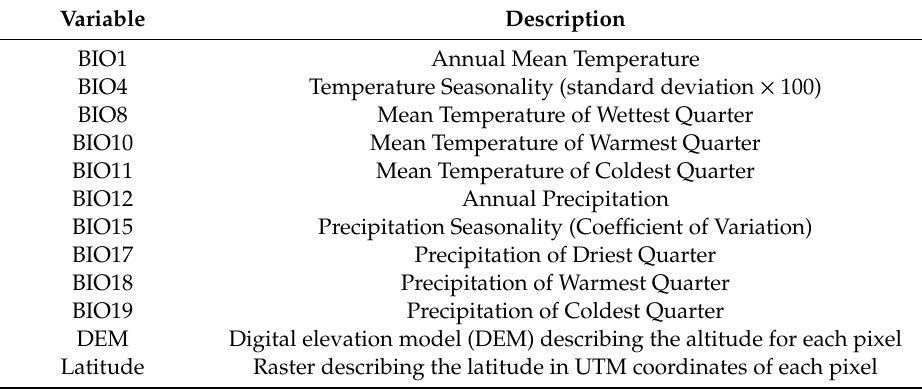
Table 1. Environmental layers used to model Cheilospirura hamulosa distribution (Source for